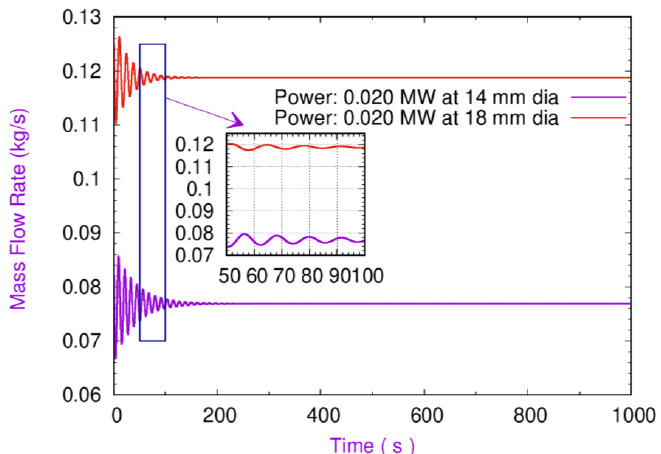
Figure 5. Variation of mass flow rate vs. time.